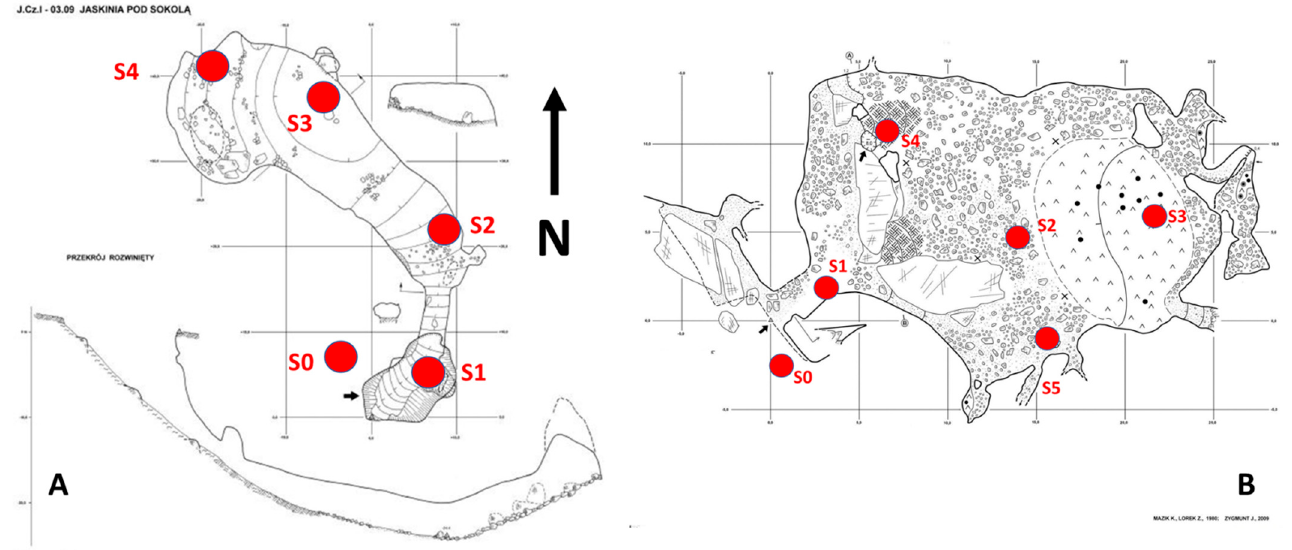
Figure 4. Diagrams of the studied caves with marked sampling points (for explanations, see the text). ( A )—Pod Sokol ą cave; ( B )—Kroczycka cave.